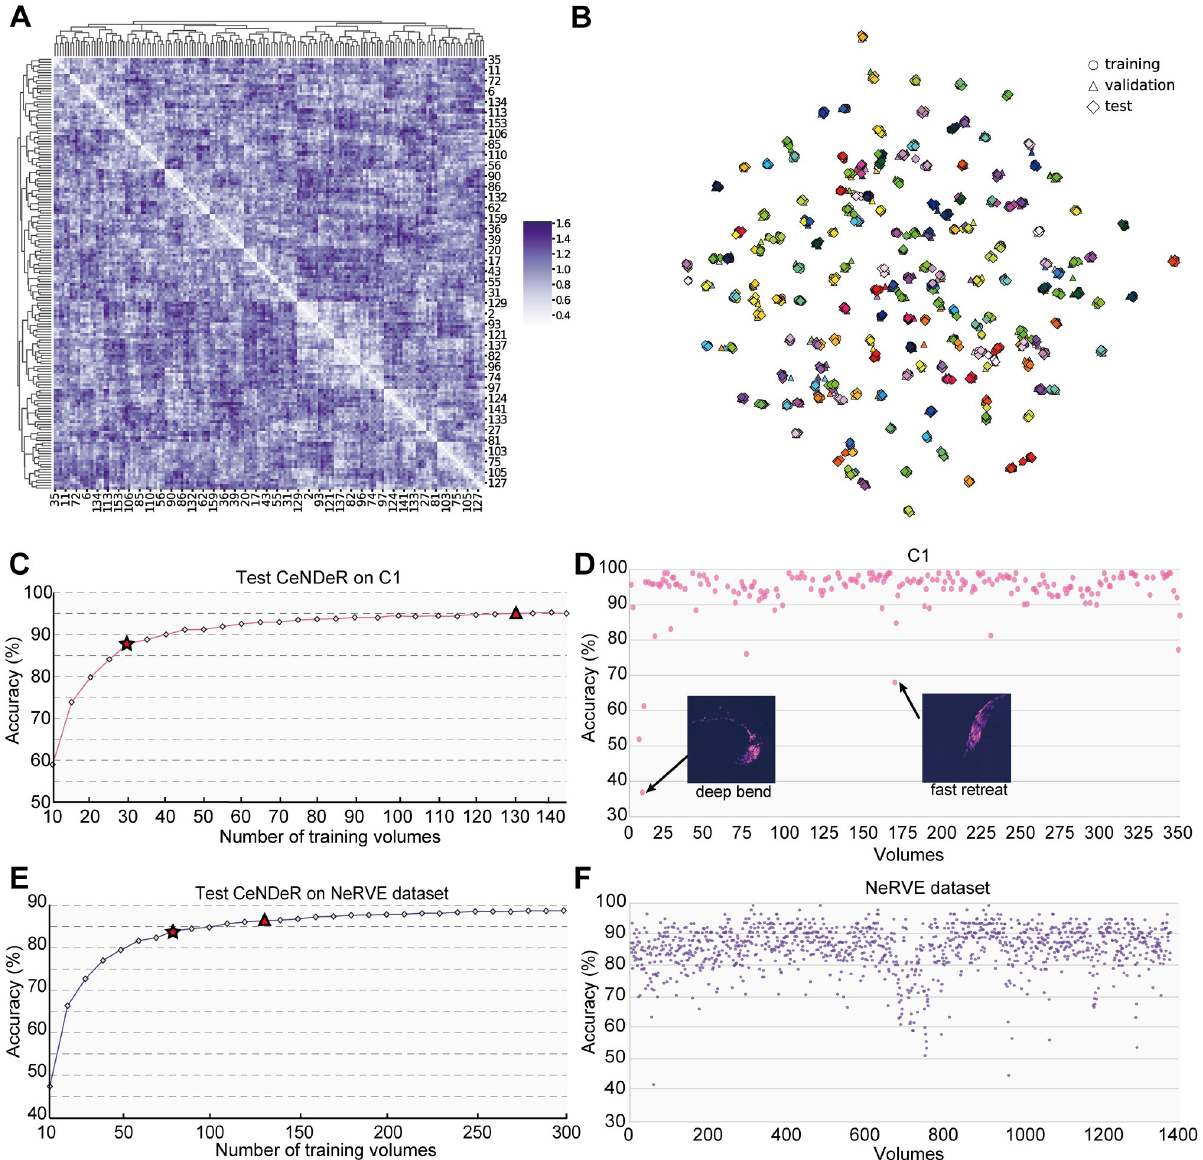
Fig 8. Neuronal feature embedding and classification in the recognition model. (A) Distance matrix between neuron clusters in the feature embedding space. The matrix represents the cosine distance D ¼ 1 (cid:0) w i � w j between trained weight vectors in the final layer of the recognition neural j w i jj w j j network (Fig 6C and 6D). w i can well approximate the direction towards the corresponding neuron cluster center. (S2(B) and S2(C) Fig). The matrix indices, representing digital IDs, are rearranged by the hierarchical clustering method. D min = 0.28, D max = 1.62 when values along the diagonal are excluded, suggesting large inter-cluster distance. (B) t-SNE visualization of the feature embedding space. The low-dimensional representation reveals intra-class similarity (S2(A) Fig) and inter-class differences among neurons (related to A ). For the sake of clarity, feature vectors from 4% of the training, validation and test volumes are drawn. (C) Train CeNDeR on C1 with different number of randomly chosen volumes and then test on the remaining volumes of C1. The top-1 accuracy reaches 88.25% with 30 training volumes (star), while the triangle denotes a 95.48% accuracy with 130 training volumes. (D) Overall tracking accuracy of C1 across 200 test volumes when the neural network was trained on 130 volumes. Inset shows MIP images of two cases with low recognition accuracy. (E) Train CeNDeR on NeRVE dataset with different number of randomly chosen volumes and then test on the remaining volumes of NeRVE. The top-1 accuracy reaches 84.10% (star) with 80 training volumes, the best performance among existing tracking methods (see Table 4). The triangle denotes a 86.51% accuracy with 130 training volumes. (F) Overall tracking accuracy of NeRVE dataset across 1222 test volumes when the network was trained with 130 volumes. In D , F , the horizontal axis represents the volume index over time.